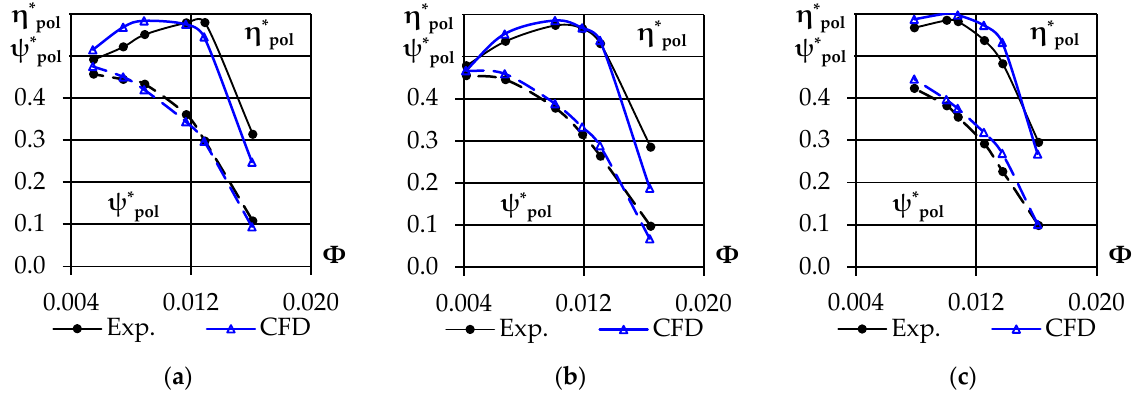
Figure 9. Comparison of experimental and calculated model stage characterizations with ( a ) 4 atm, ( b ) 10 atm, and ( c ) 40 atm.